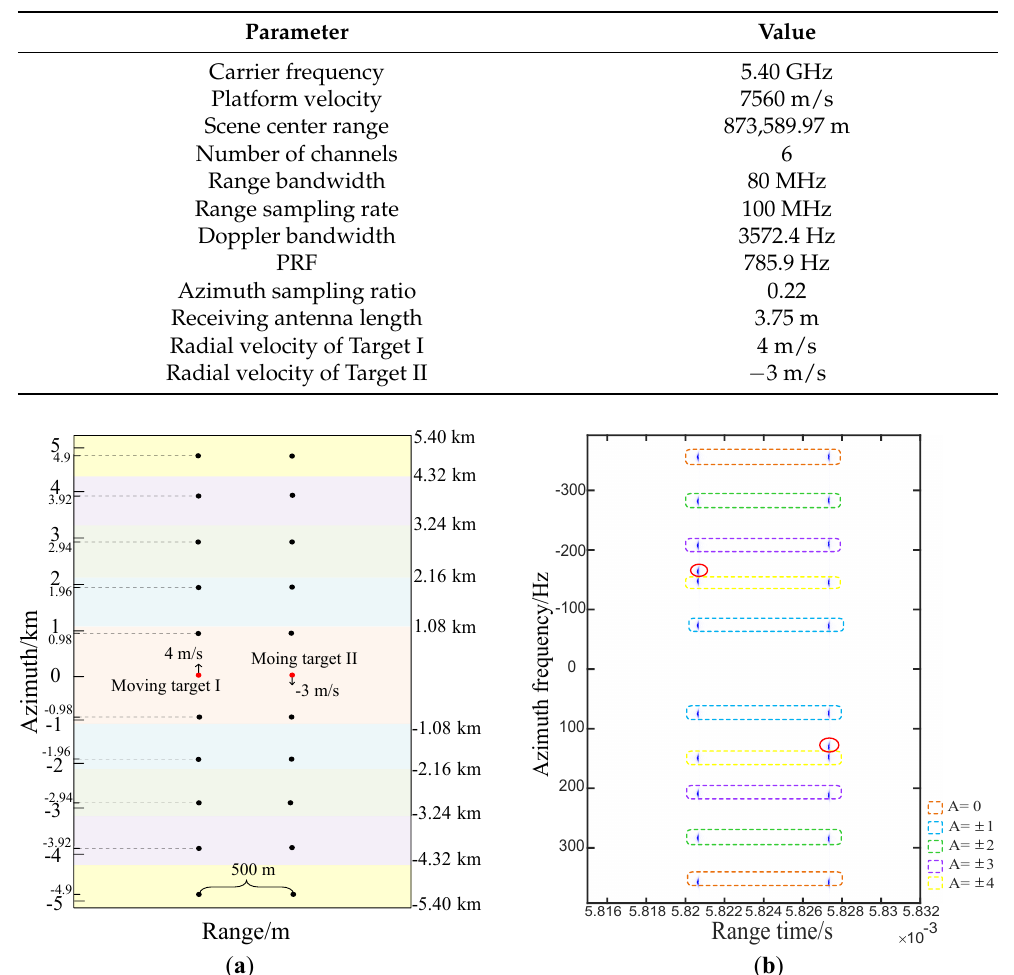
Table 1. Main parameters of the simulated HRWS SAR system.